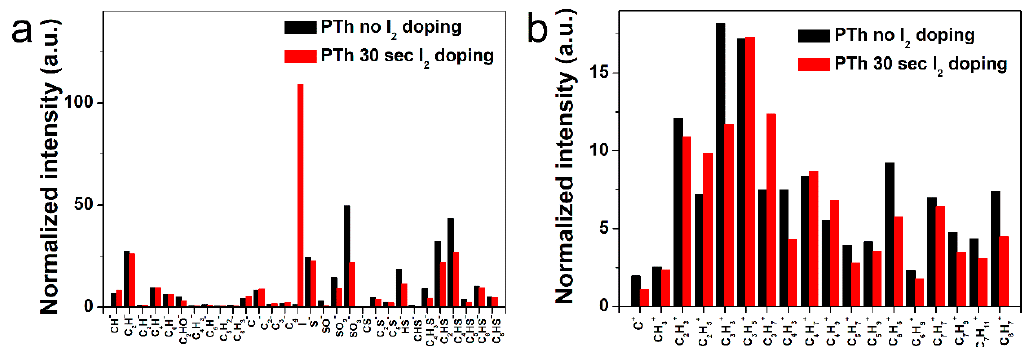
Figure 4. Normalized intensities of ( a ) negative-ion spectra and ( b ) positive-ion spectra of ToF-SIMS on surface of the plasma polymerized thiophene films without and with I 2 doping.